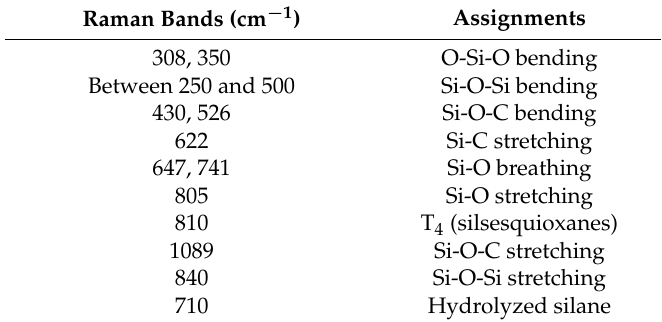
Table 8. The assignment of vibrations for Raman peaks of trifunctional silanes. Data from [54]. Copyright John Wiley & Sons,